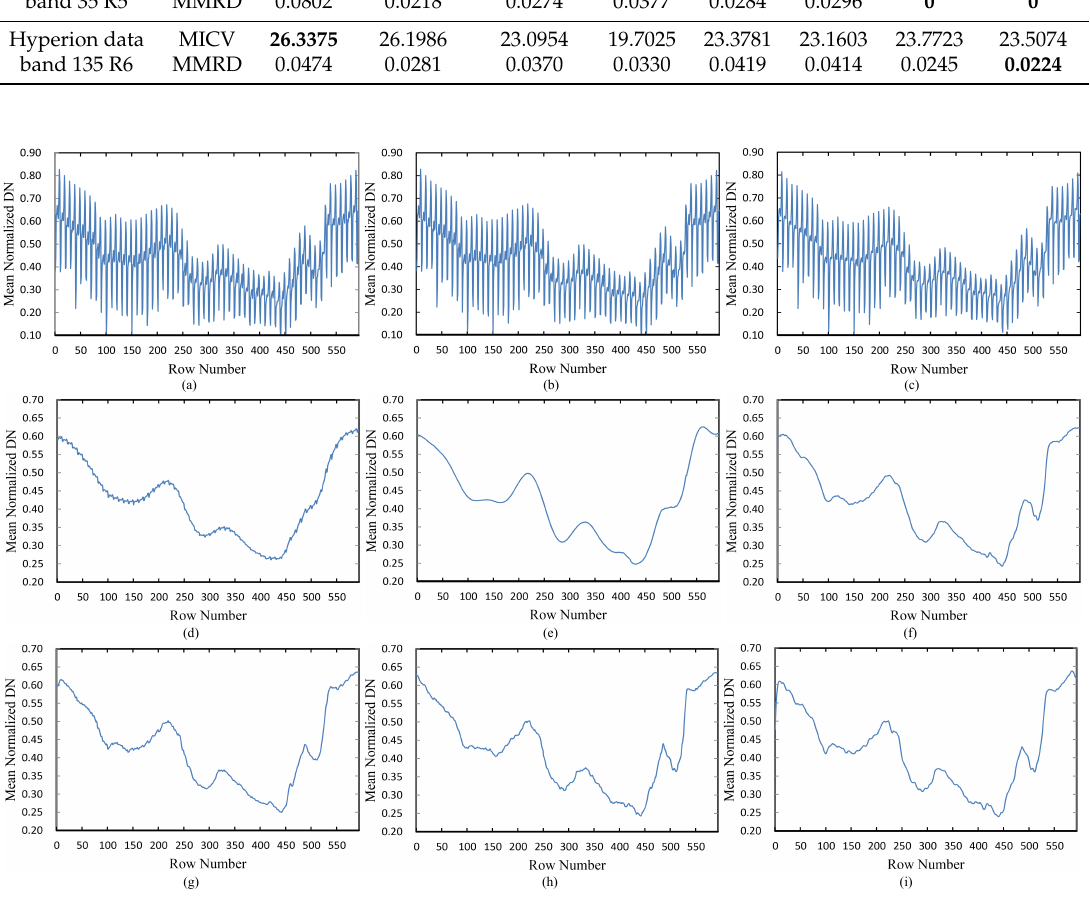
Figure 23. Mean cross-track profiles of Terra MODIS data R1. ( a ) original; ( b ) BM3D; ( c ) SNRCNN; ( d ) GF-based; ( e ) WAFT; ( f ) UV; ( g ) HUTV; ( h ) SUV; ( i )